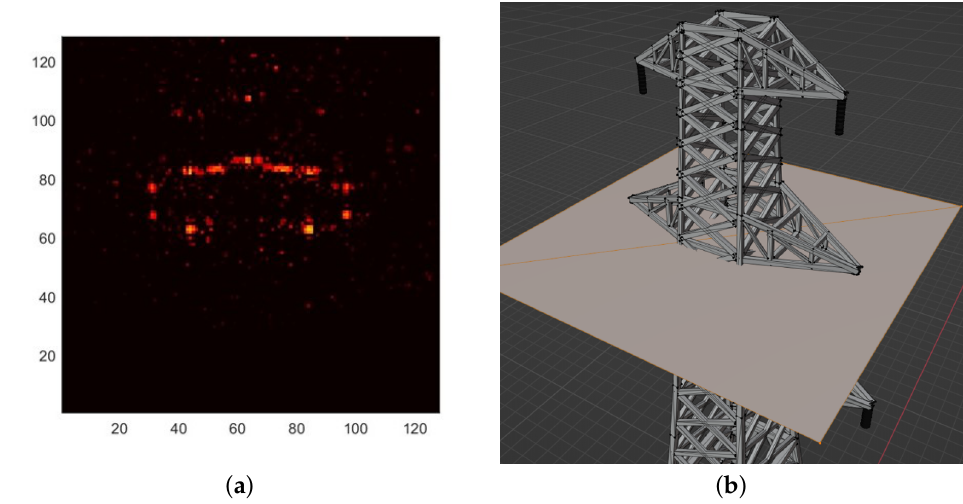
Figure 11. Height slice of electricity pylon at 23.5m. ( a ) Weighted MIRF; ( b ) Detail from CAD model.